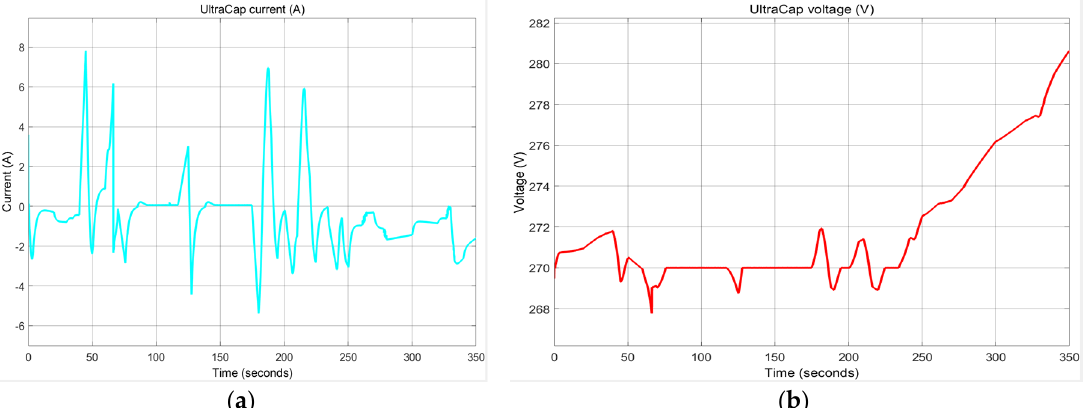
Figure A10. Li-ion battery specific variables. ( a ) Battery current; ( b ) Battery voltage; ( c ) Battery SOC.